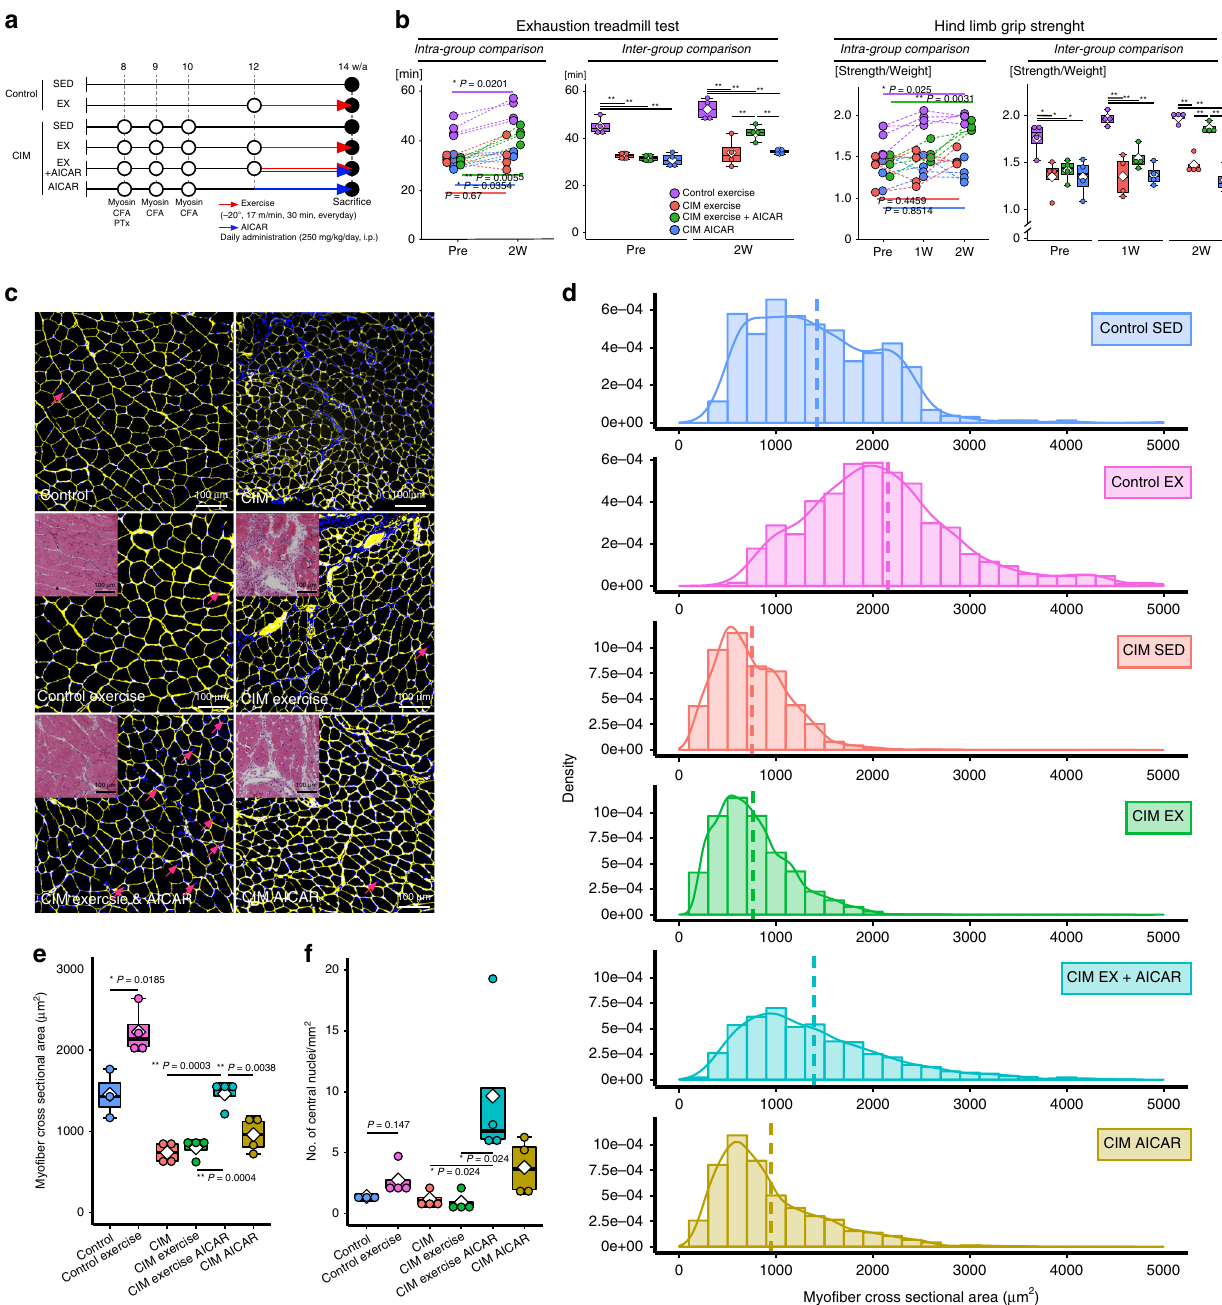
Fig. 6 Muscle strength restored in CIM mice by combined exercise and AICAR treatment. a Protocol for 2-week therapeutic intervention with exercise and AICAR treatment in control and CIM mice. b Results of the exhaustion treadmill test and hind limb grip strength test are shown as intra- (left panel) and inter-group (right panel) comparisons ( n = 3 per group). c – f Changes in muscle cross-sectional area and number of regenerating muscle fi bers in normal and CIM mice following exercise and/or AICAR treatment. c Representative images of H&E- and laminin-immunostained triceps surae (yellow) and nuclei (blue). Arrows indicate the central nuclei of regenerating muscle fi bers. d The distribution of cross-sectional triceps surae fi ber areas, with the mean area indicated by the dotted line. e , f Quantitative data of muscle cross-section area and the number of regenerating muscle fi bers ( n = 3 for control, n = 4 for exercise and CIM). Data are shown as a dot plot for each specimen, and as means as well as medians with IQRs and 1.5 times the IQR by dot plots and box and whisker plots. P values were determined by the paired t test or one-way ANOVA adjusted by the Holm method (* P < 0.05, ** P <